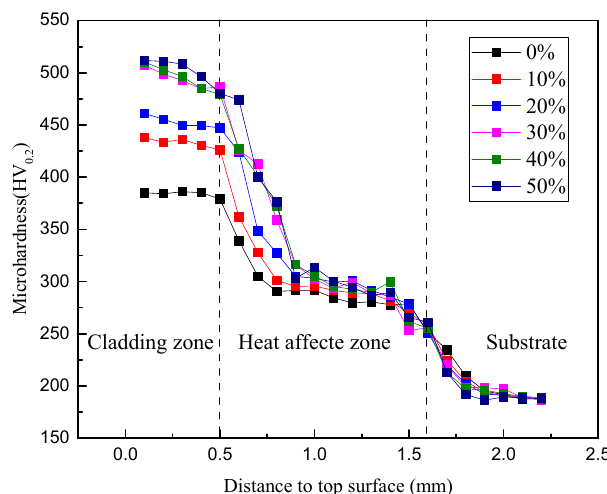
Figure 5. Microhardness distribution in laser cladded Ni45 + high-carbon ferrochrome coatings.